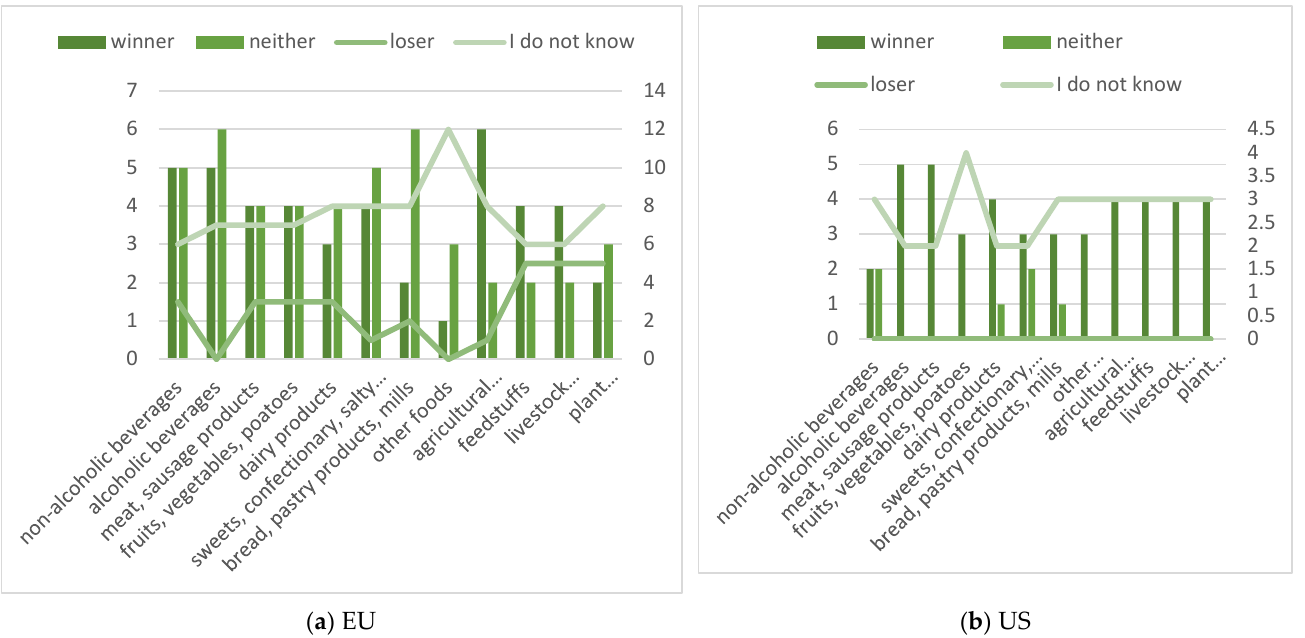
Figure 3. Winners and losers of the TTIP: ( a ) in the EU; ( b ) in the US; absolute values. Source: own calculation.